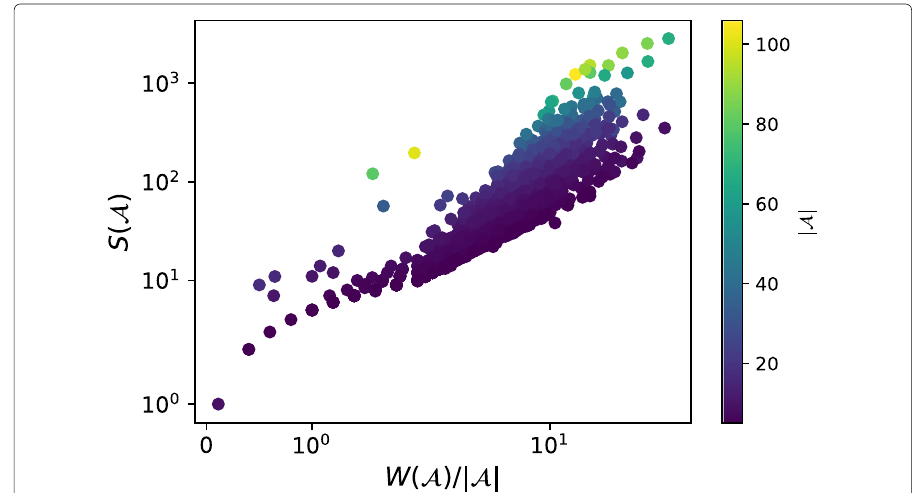
Fig. 7 A colour plot showing a relation between siblinarity score of an antichain A , S ( A ) , W ( A )/ | A | and | A | for an antichain partition obtained in hep-th citation network. Antichains were obtained considering co-citations. Figure shows that siblinarity scores, obtained by antichains relate to W ( A )/ | A | but not to the size of an